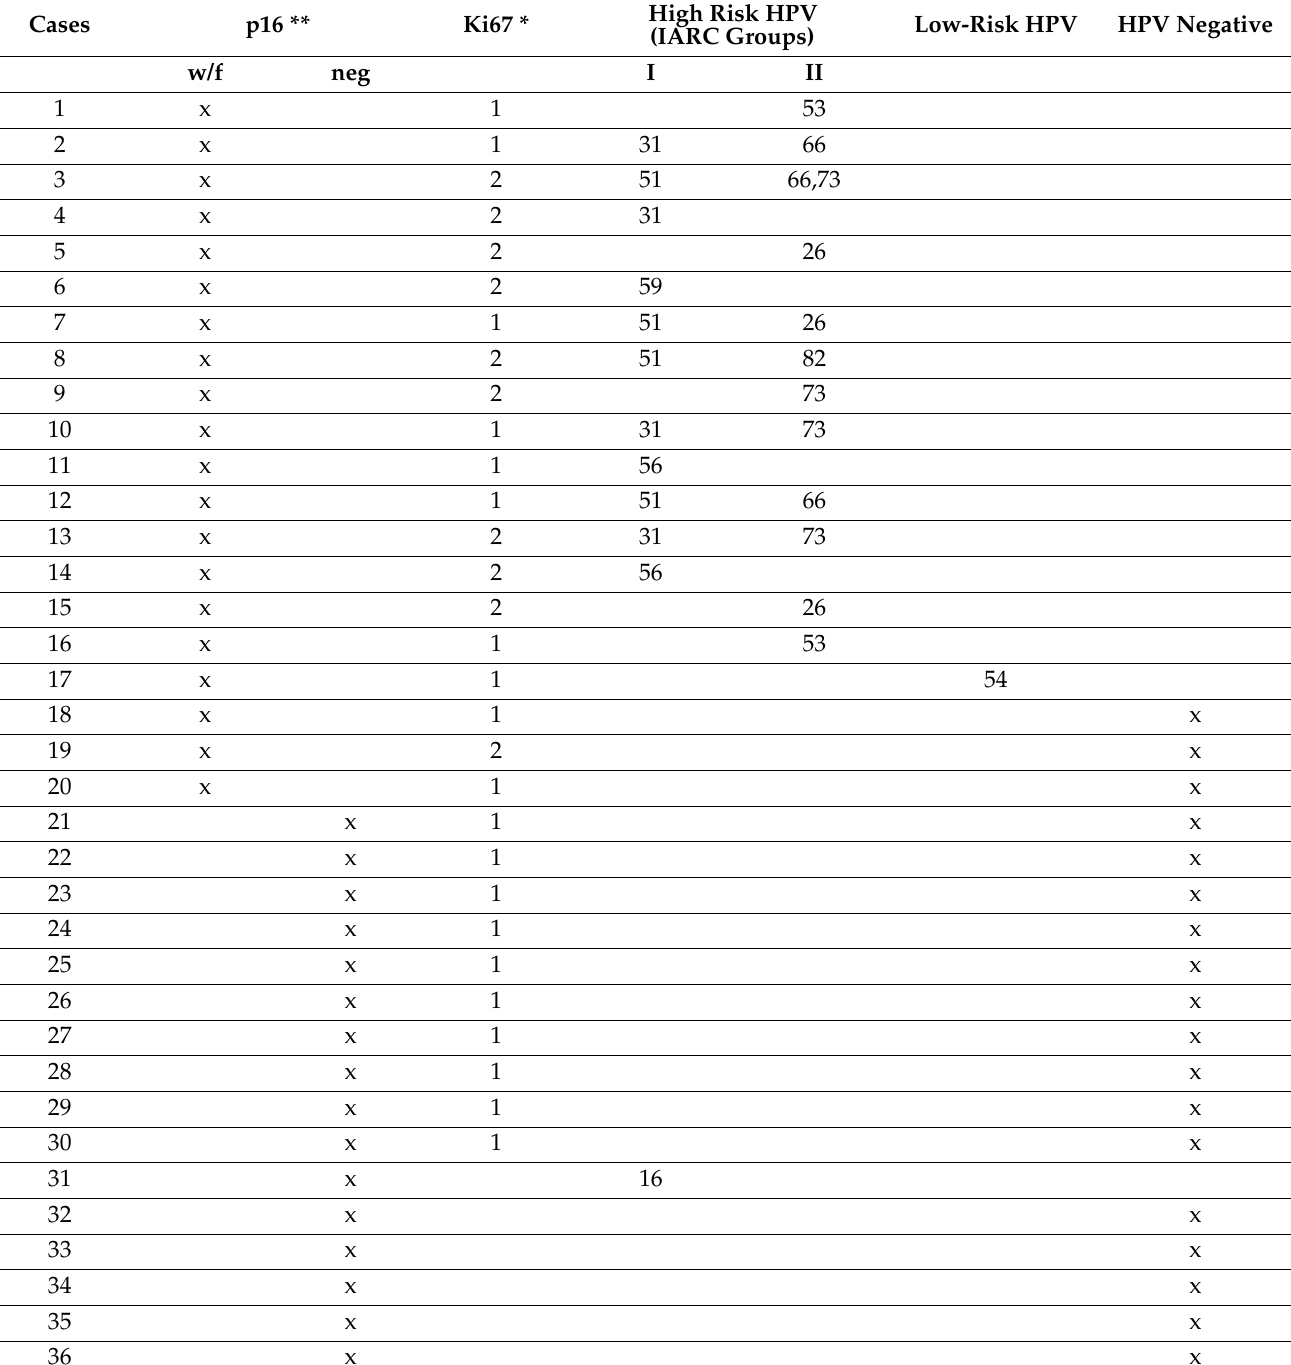
Table 1. Cases 1–20: Cervical atypical lesion with focal and weak p16 staining (w/f p16+ CALs). Cases 21–40: cervical atypical lesion negative for p16 immunostaining (p16-